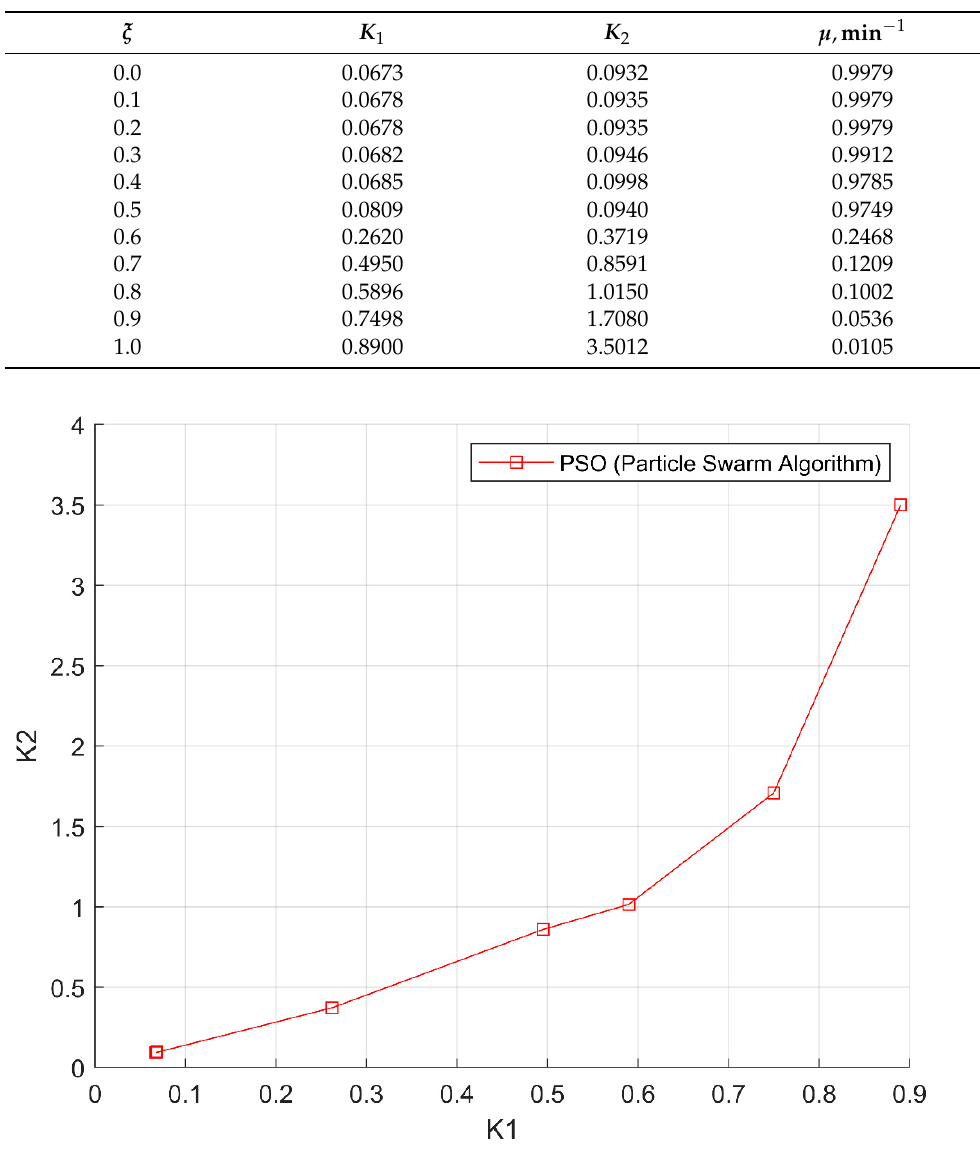
Figure 3. Pareto-optimal set for solving a problem by a method using a particle swarm algorithm. Table 3. Optimization results by the method using a backtracking search